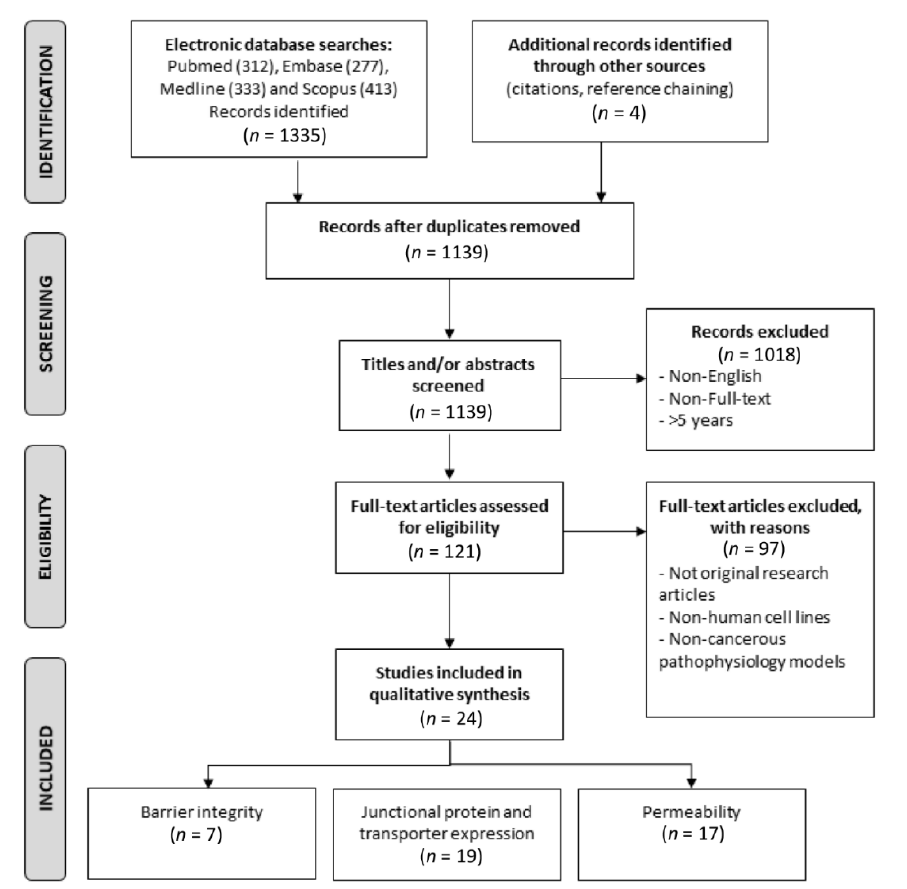
Figure 1. PRIMSA flowchart of the study selection process methodology for the systematic review. Keyword combinations used in the electronic database searches are outlined in Table S2. Figure adapted from Moher and colleagues [14].